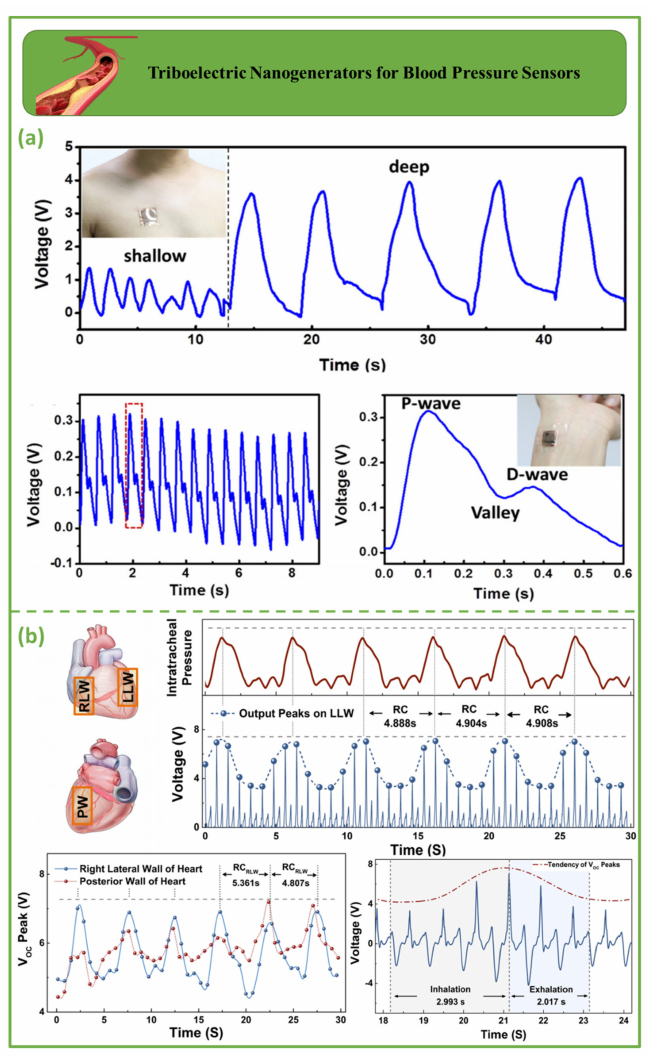
Figure 6. Demonstration of triboelectric nanogenerators for blood pressure sensors. ( a ) Triboelectric nanogenerators based on expandable microspheres as highly sensitive pressure sensors to monitor both the respiratory system and the pulse [91]. ( b ) Schematic representation of the left lateral wall (LLW), right lateral wall (RLW), and posterior wall (PW) from anterior and posterior cardiac views